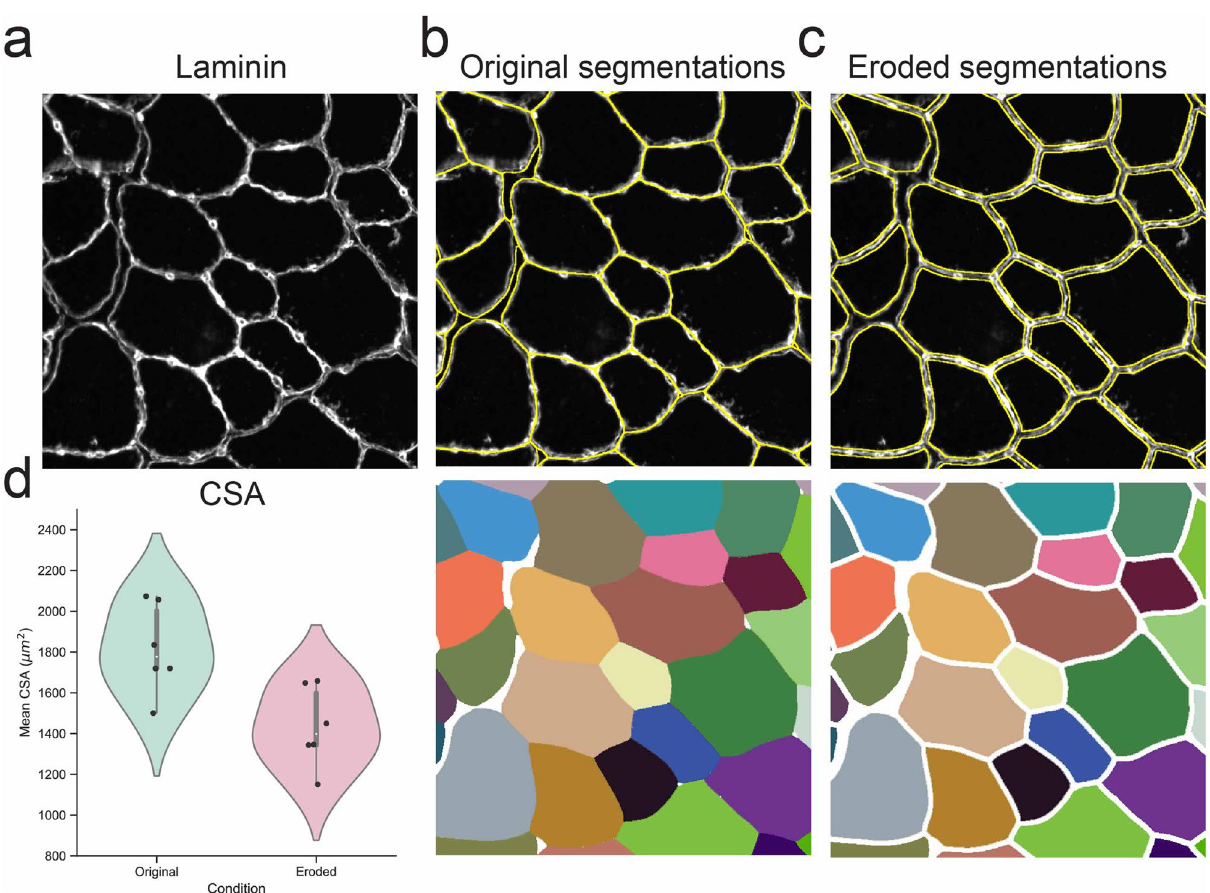
Figure 5. Erosion of Cellpose segmentations is needed for accurate CSA measurements. ( a ) Example of a snap- frozen Laminin stained TA cross-section. ( b ) Cellpose segmentation of the image in ( a ) showing the overlaid segmentations in yellow (top) or the Cellpose-generated label image (bottom). ( c ) Segmentation results after the Cellpose label image was eroded by 4 pixels. ( d ) Mean CSA for all myofiber of Laminin stained TA muscle cross- sections of 6 different mice with or without a 4-pixel label